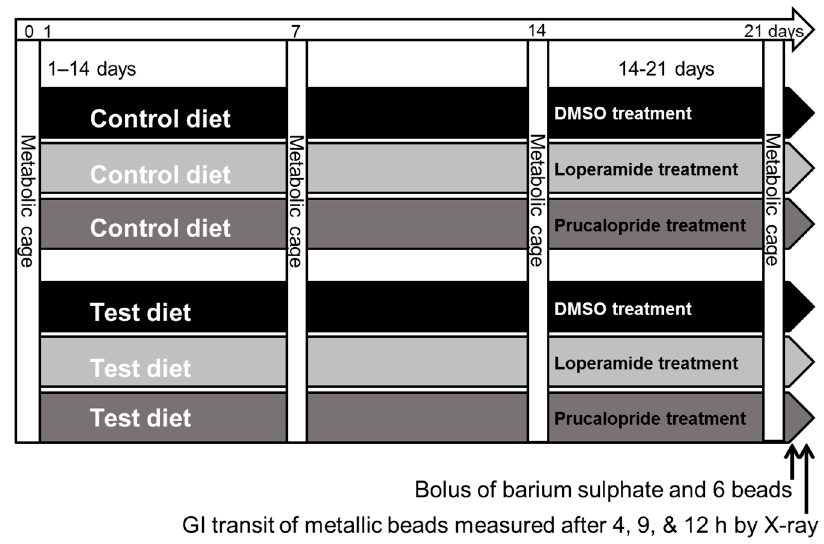
Figure 1. Study design shown for the dietary control (hydrolyzed soy) and one of the five milk protein test diets. GI, gastrointestinal; DMSO, dimethyl test diets. GI, gastrointestinal; DMSO, dimethyl sulfoxide.